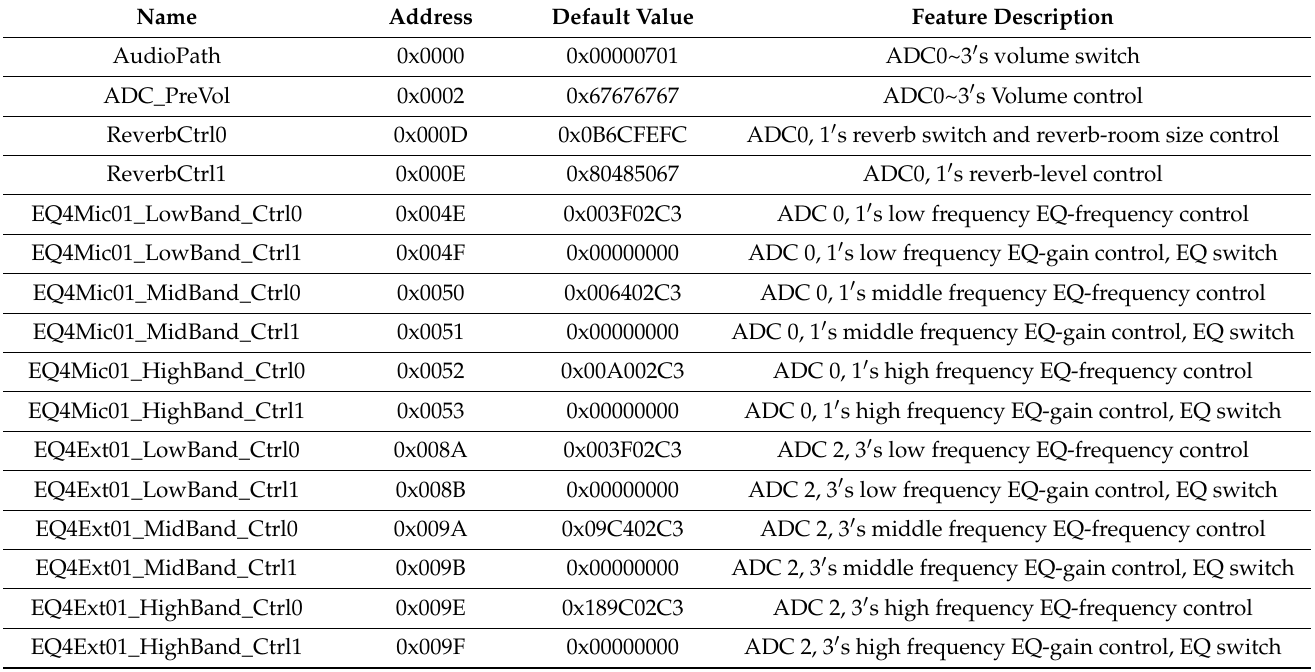
Table 2. Partial function of the control registers in DSP (KT0707).